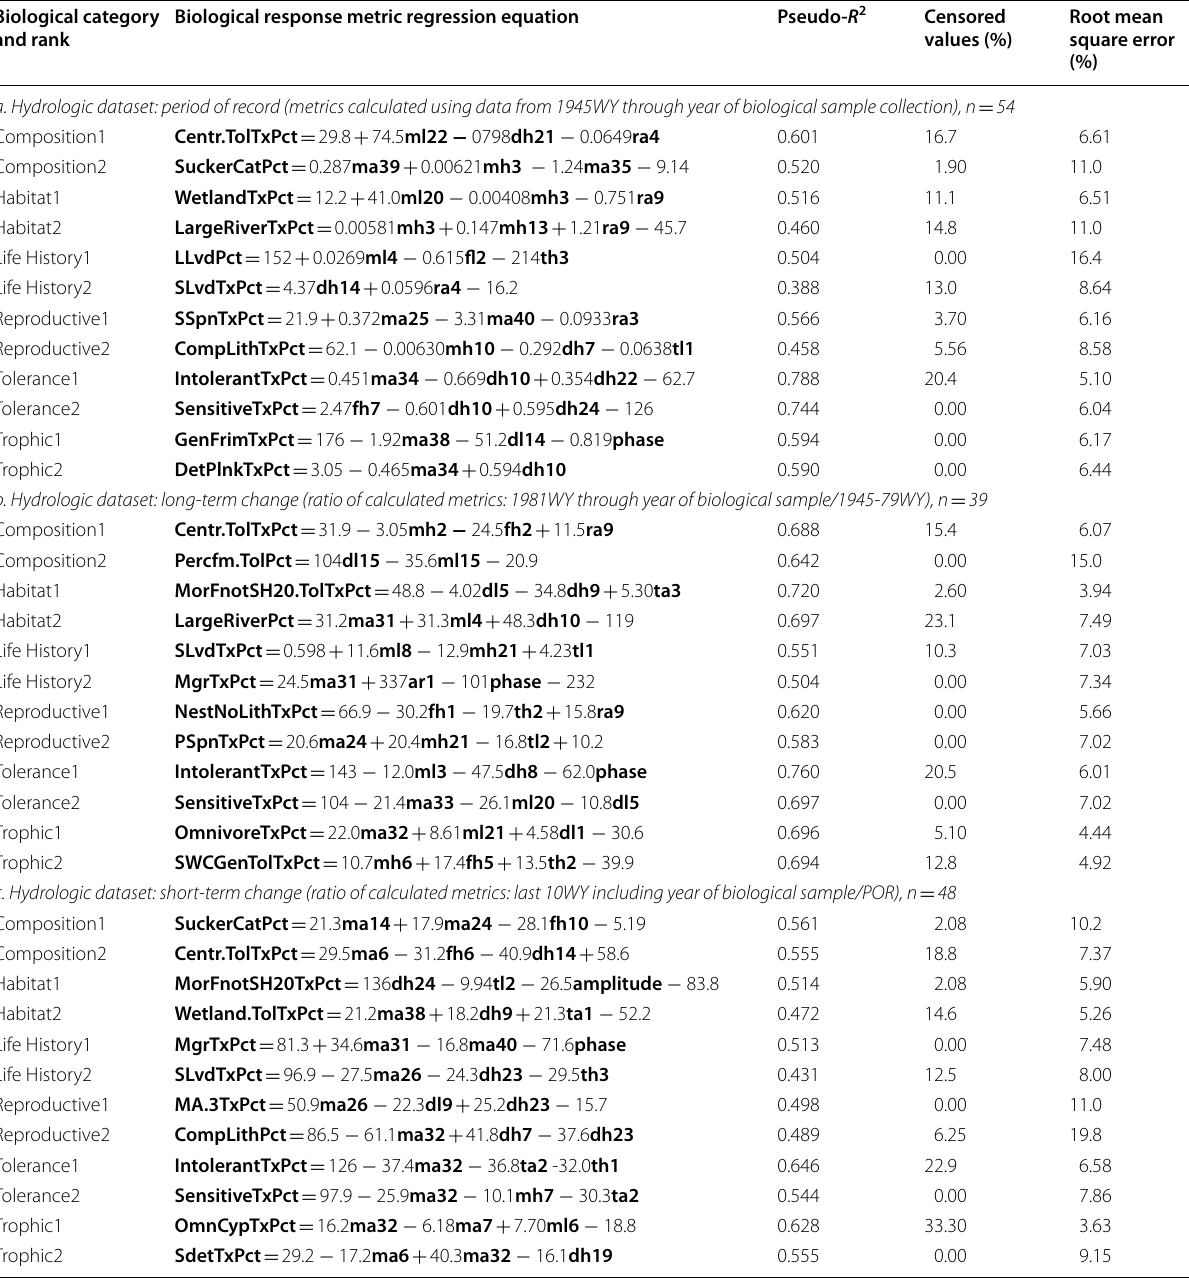
Table 4 The two best regression models and fit statistics for six categories of fish-based biological metrics across three hydrologic datasets; see Table 1 for definitions of the biological metrics (response variables) and Table 2 for definitions of the hydrologic metrics (explanatory